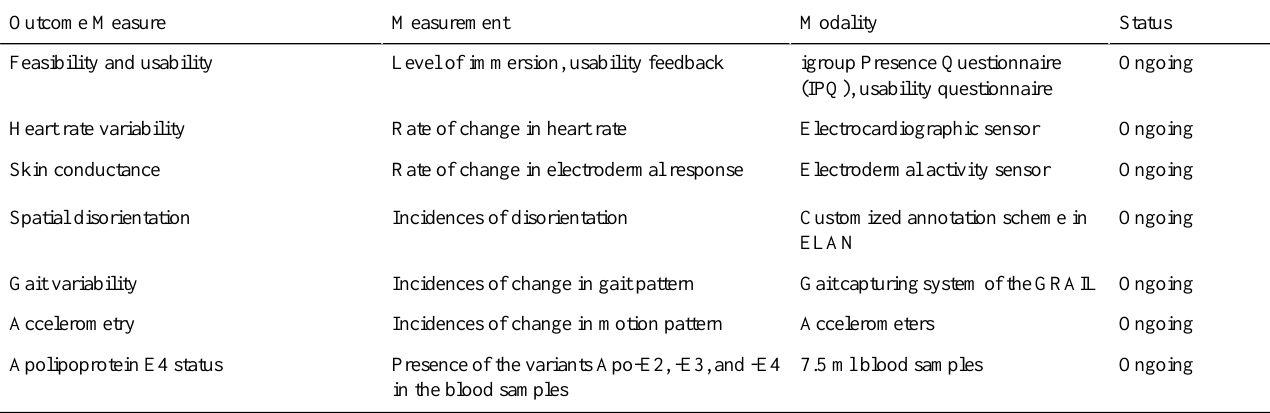
Table 2. Study outcome